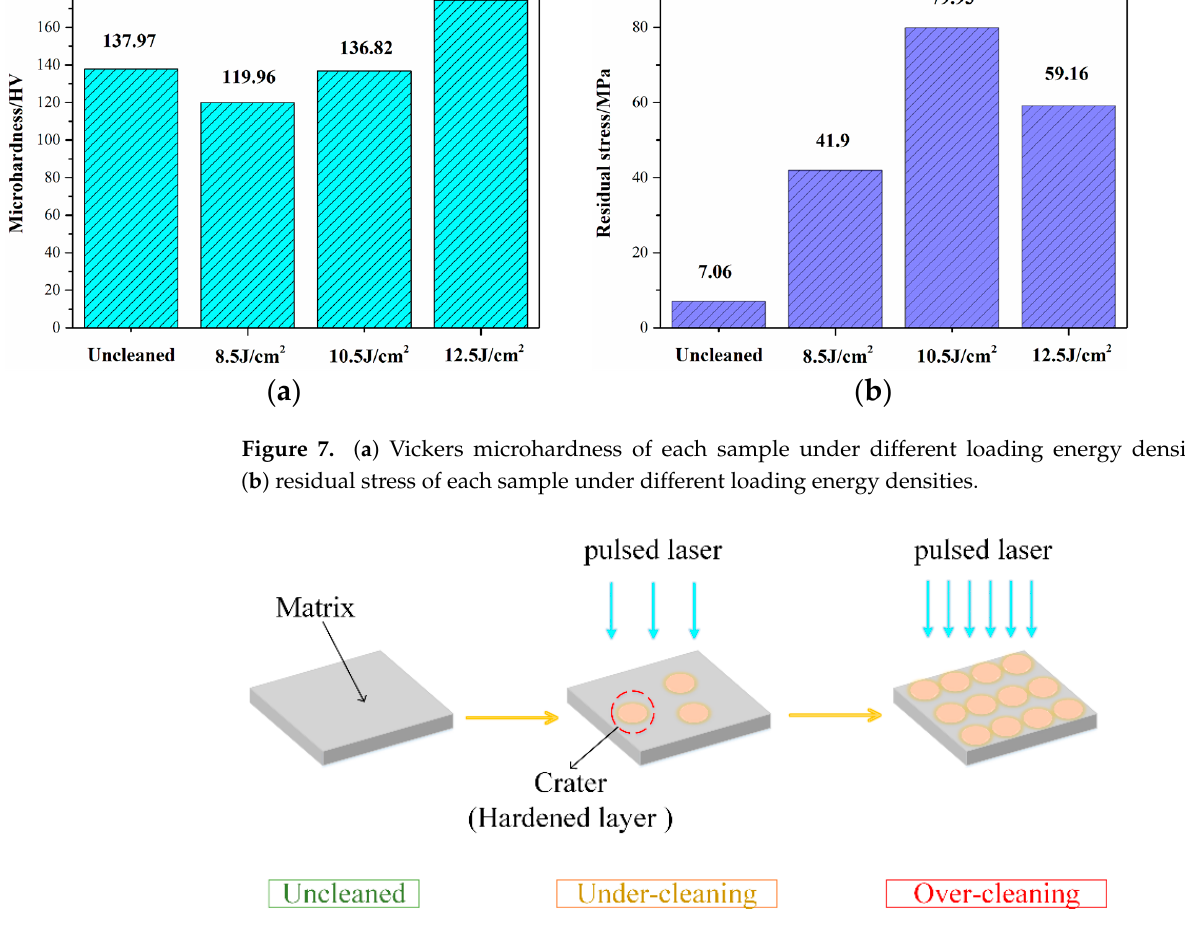
Figure 8. Principal surface hardness strengthening of the aluminum alloy.